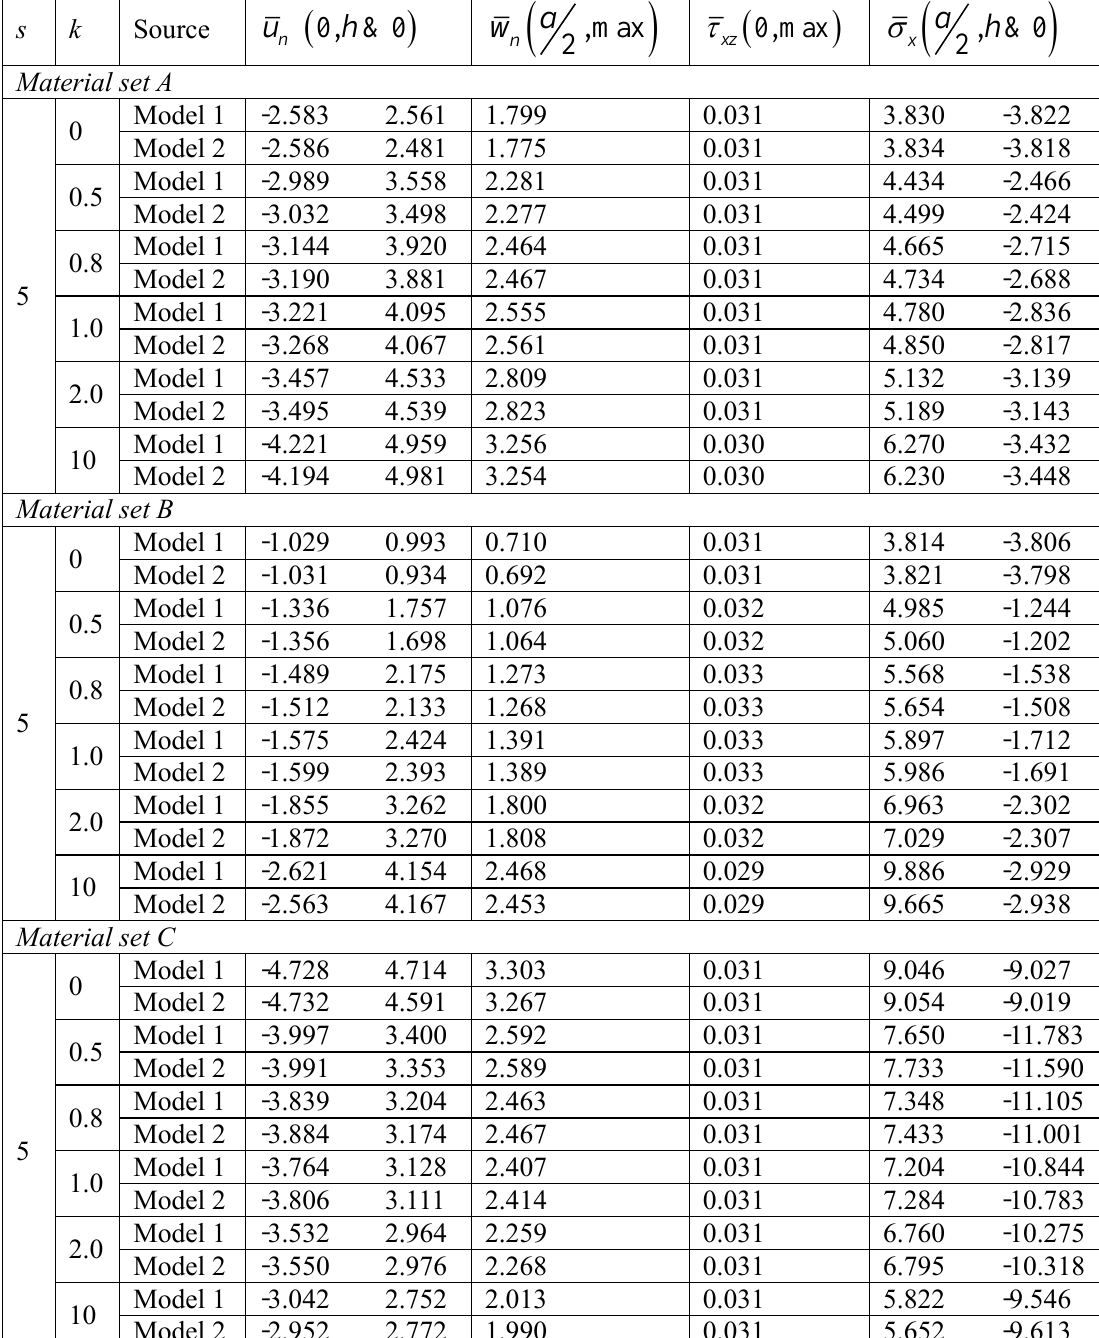
Table 5 Normalized in-plane and transverse displacements thermomechanical loading for material set A, B, and